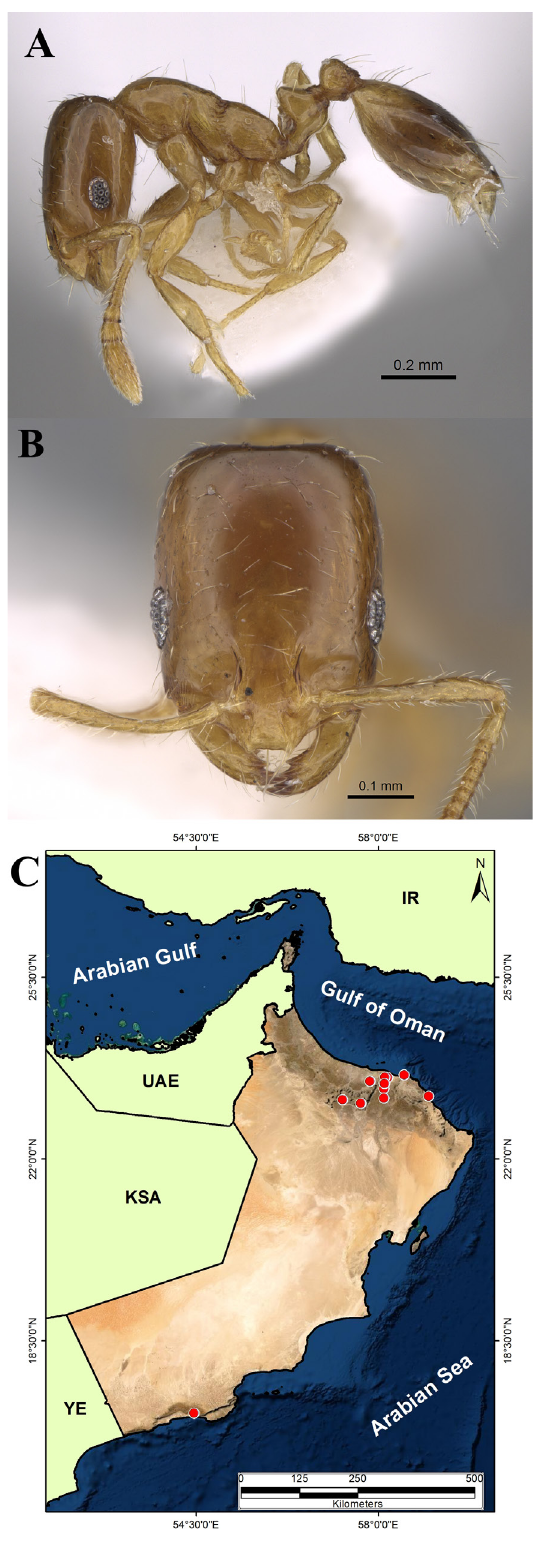
Fig. 39. Monomorium exiguum Forel, 1894, worker (CASENT0922878, AntWeb.org (Michele Esposito)). A . Body in profile. B . Head in full-face view. C . Distribution